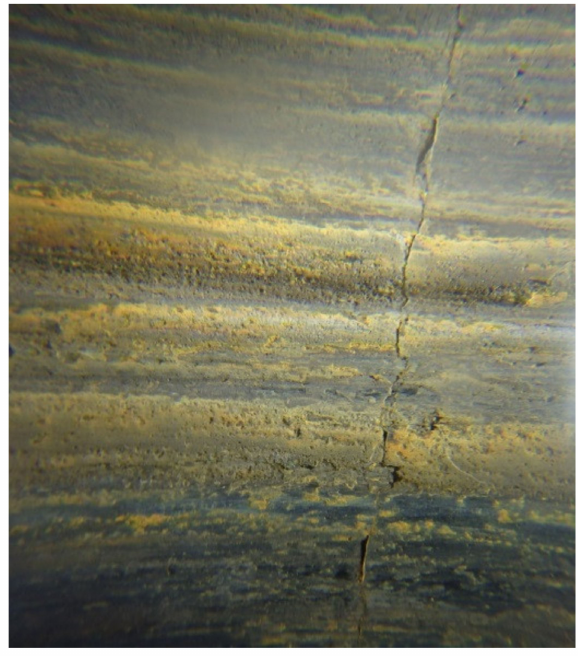
Figure 7. Crack of a guide ruler. Source: own research.